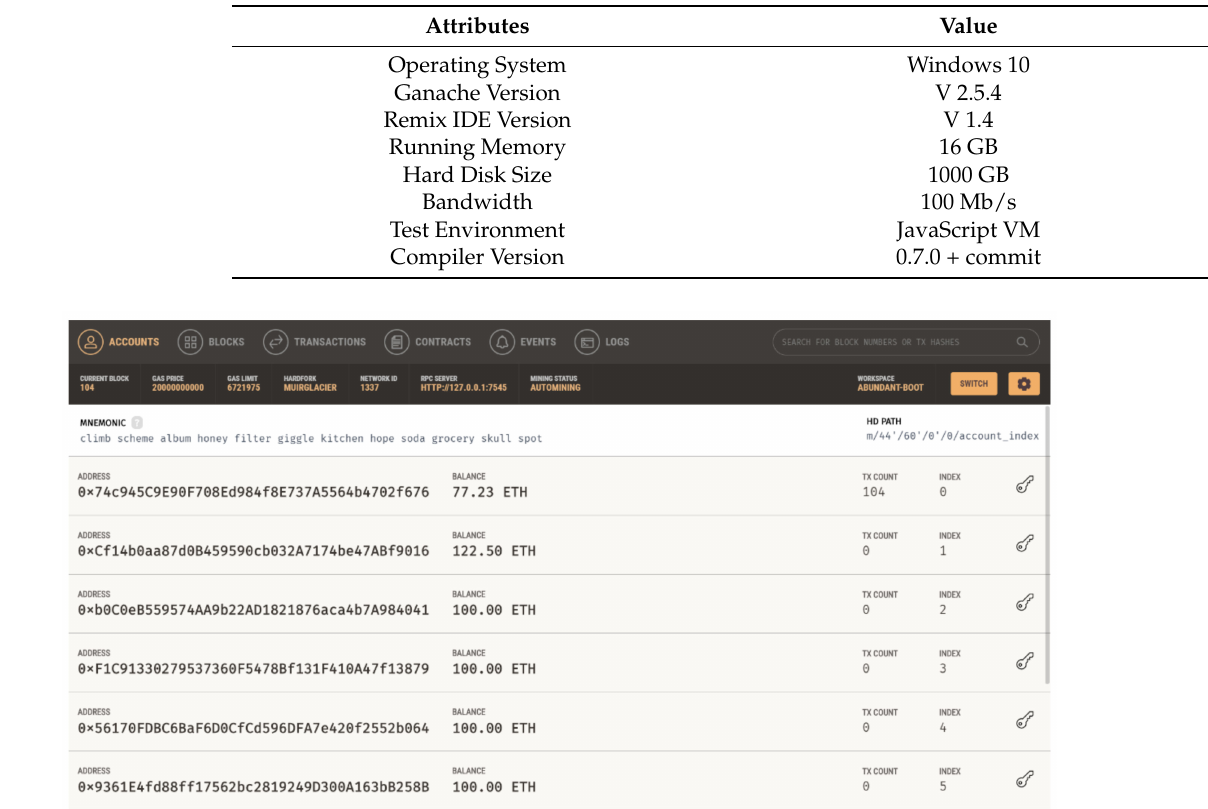
Table 2. System Settings.